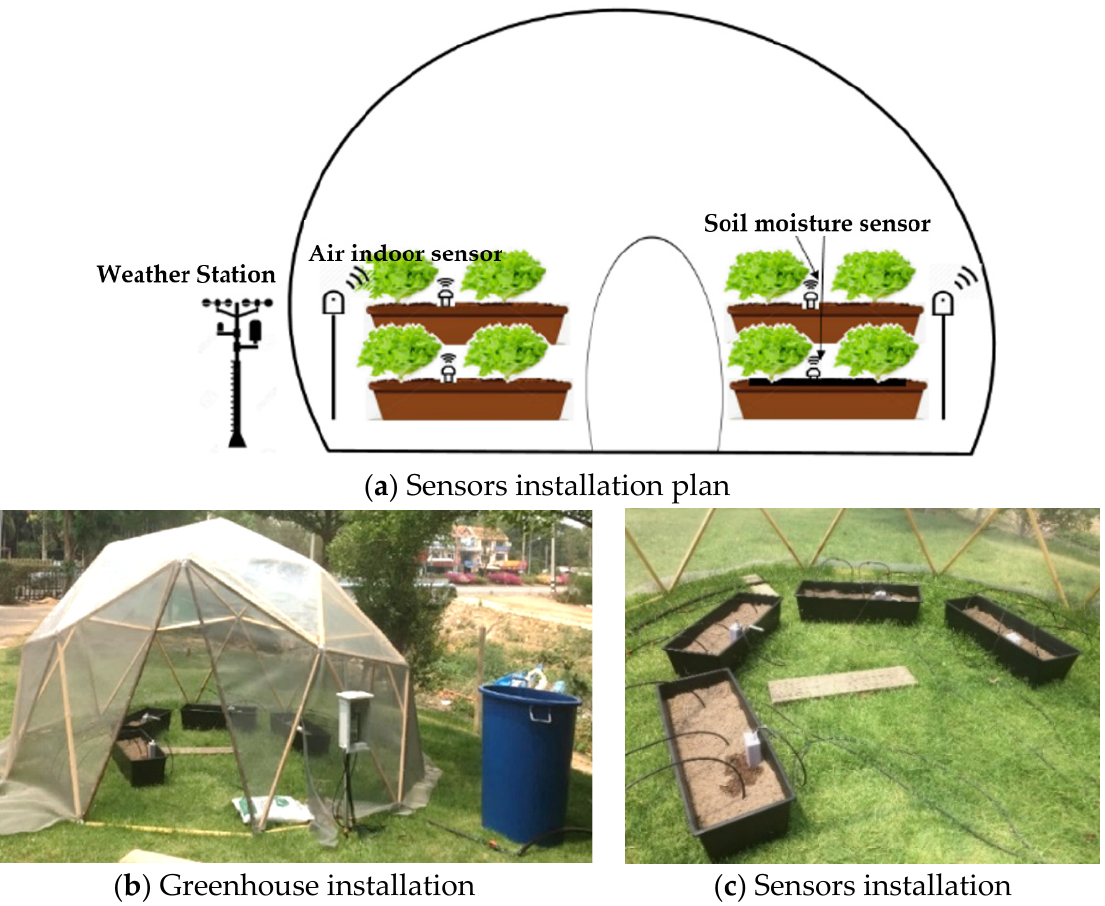
Figure 2. Multiple sensors installed for data collection (1 set of soil moisture sensors, 1 set of air indoor sensors, 1 weather station, and 1 set of water sensors). Table 1. Collected data and their